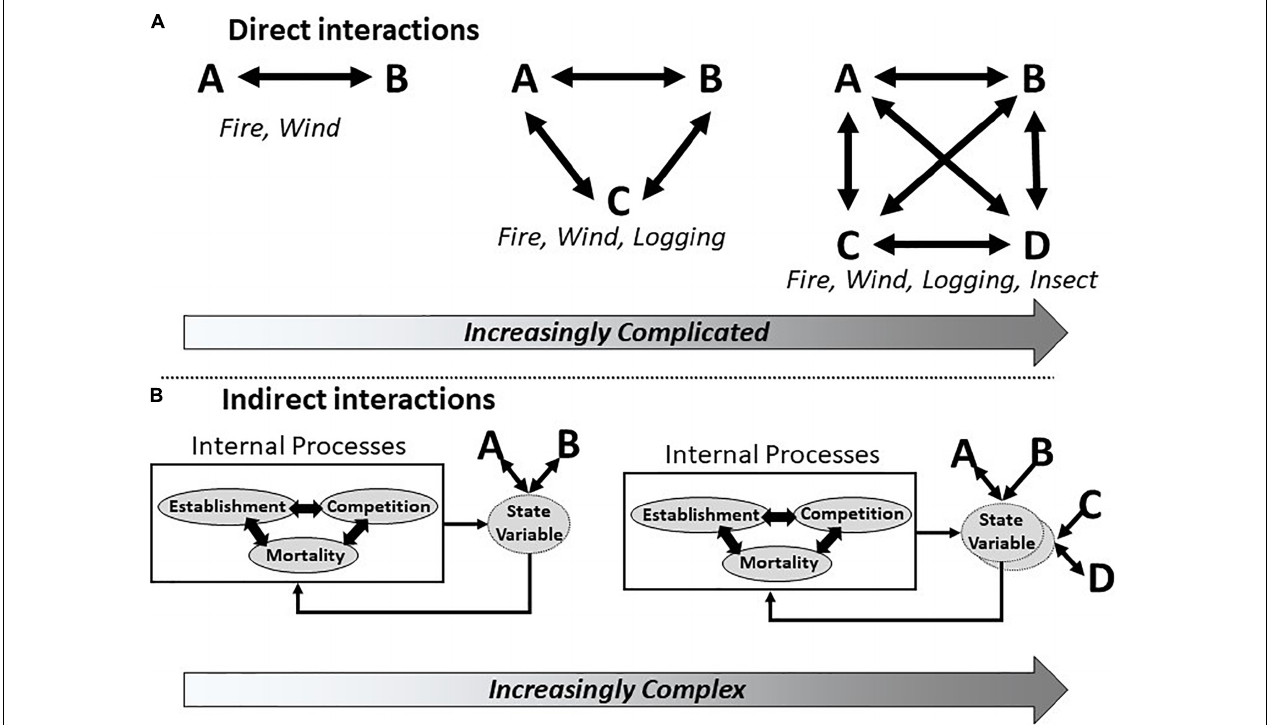
FIGURE 7 | Challenges and approaches to simulating multiple disturbance interactions. When disturbance interactions are simulated as direct (A) , the number of interactions can multiply quickly to become increasing complicated, especially if the interactions are bidirectional (i.e., double-arrows). Indirect interactions are those mediated through ecosystem state variables, such as composition or fuel (B) . Depending on model design, it may be more elegant (i.e., fewer interactions) to explicitly model the indirect processes affecting disturbance processes, but such models may also be more interdependent and therefore more complex